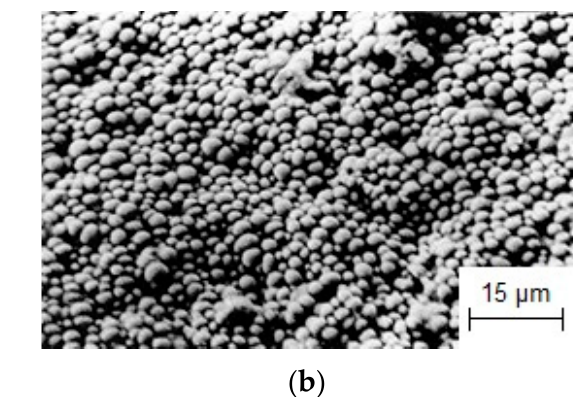
Fe Cr 7 C 3 ▲ Figure 6. XRD patterns of the refractory carbide coatings on the St3 steel substrate (solid line), data points indicate the reference samples. 3.2.2. Protective Properties of Refractory Carbide Coatings Cross-section was used to determine the thickness of synthesized refractory metal carbide coatings. In general, the thickness of the coatings obtained by the CT method de- pends on the duration of the process, the diffusion rate, and the carbon content in the substrate. In our case, the coating thicknesses were 1–2 microns. The morphologies of ni- obium carbide coatings formed at various synthesis durations on St.3 steel are presented in Figure 7. The coatings were composed of densely packed spherical particles with a di- ameter of 1–2 μ m. If the synthesis time was 3 h (Figure 7a), the coating was not continuous. To obtain continuous coatings, the synthesis time was increased to 8 h (Figure 7b). Samples coated with Cr 7 C 3 , NbC and TaC were tested for corrosion resistance in con- centrated mineral acids and for wear resistance by the following methods. The corrosion rate was determined by a gravimetric method using cylindrical samples with a length of 30 mm and a diameter of 7 mm. After deposition of the coatings and electrolyte removal, the samples were degreased with refined ethyl alcohol. The corrosion rate was determined at 298 K for 48 h as a mass loss of the sample through a surface area unit per unit of time. At the end of the sample exposure in concentrated mineral acids, corrosion products were removed mechanically, the samples were degreased again, and were weighed on analyt-